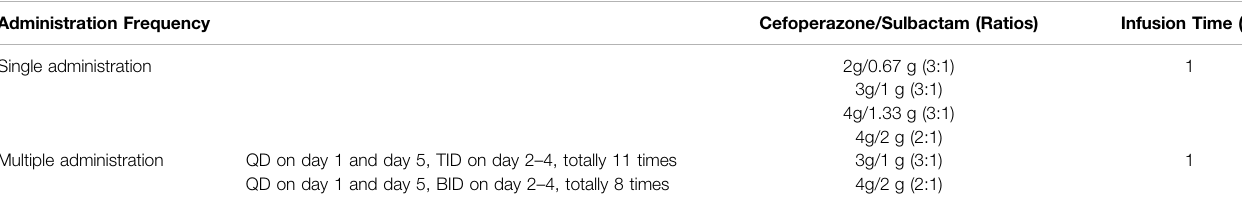
TABLE 4 | Designed dosing regimens. Administration Frequency